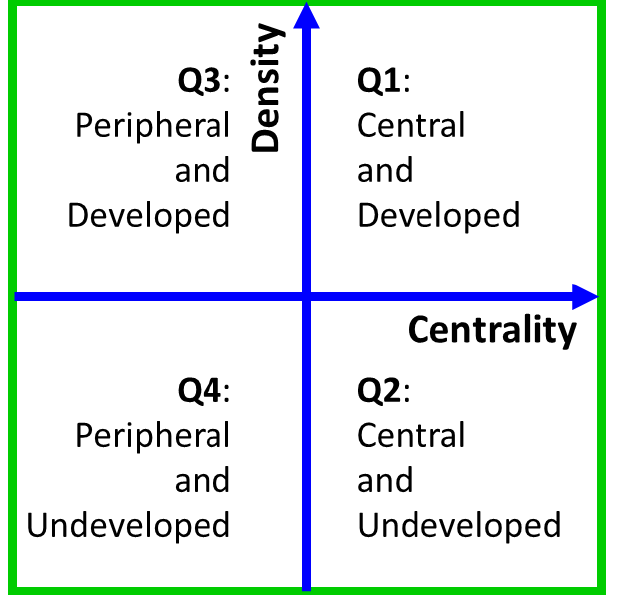
Figure 9. Basic themes of a thematic map.